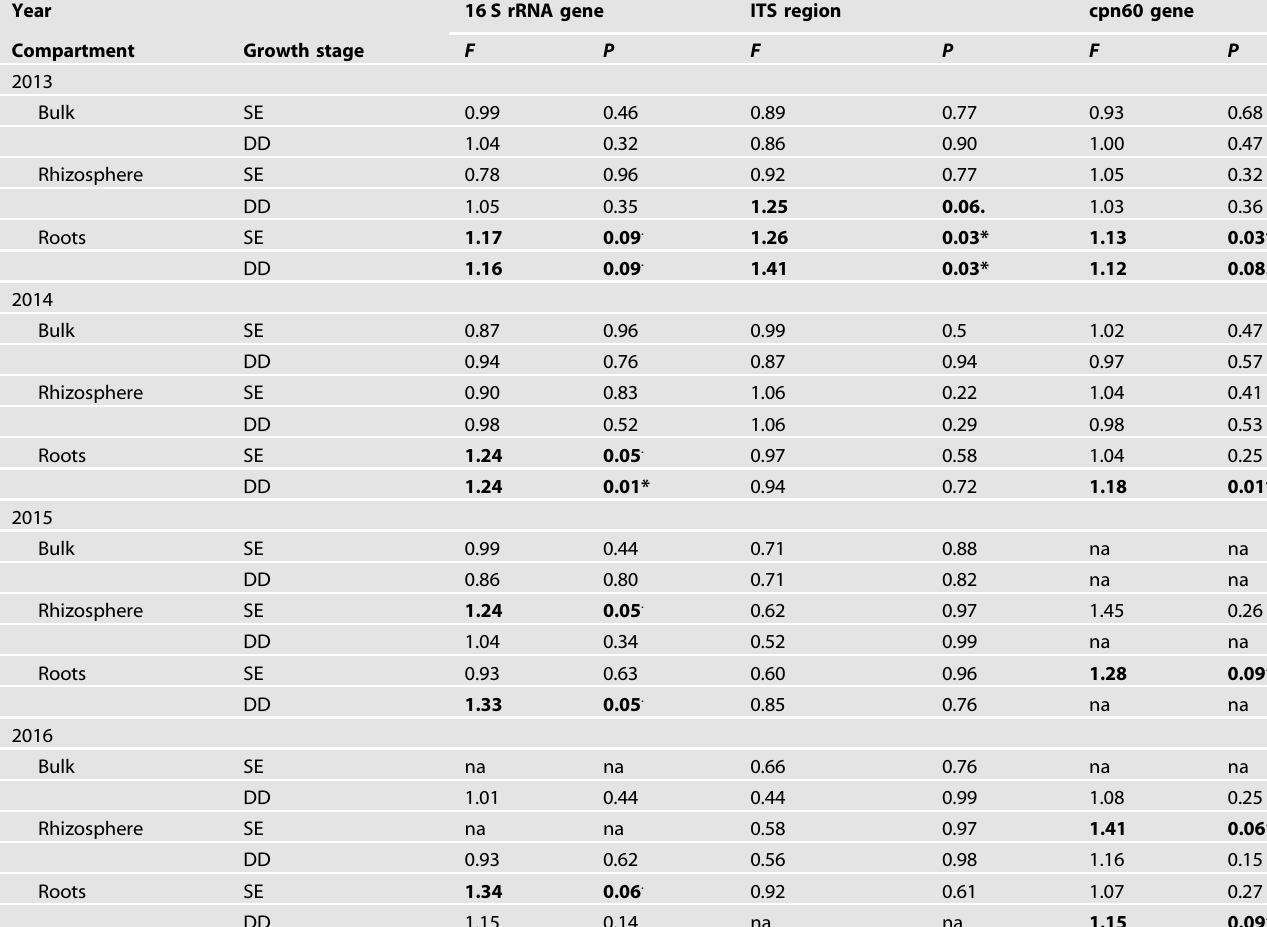
Table 3. Permanova analyses for the effect of genotype for each year/compartment/growth stage combinations for 16 S rRNA gene, ITS region and cpn60 gene amplicon datasets generated from bulk soil, wheat rhizosphere soil and wheat roots collected from 2013 to 2016 at the stem elongation and dough development